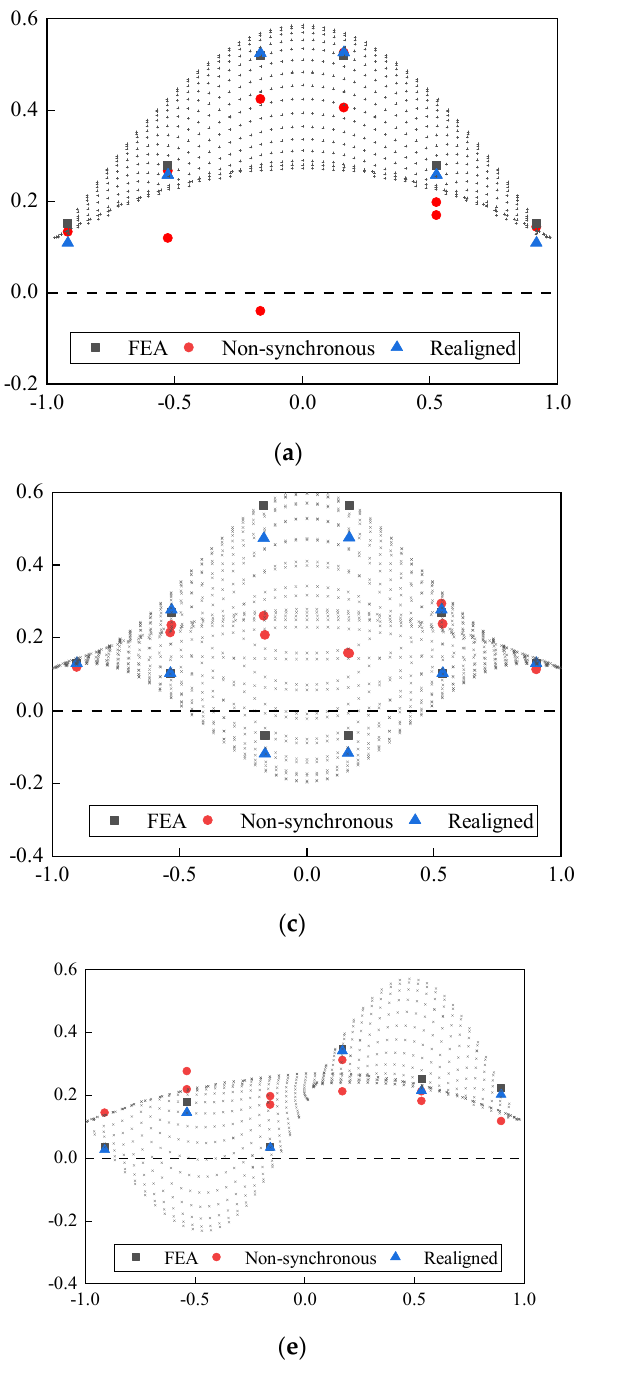
Figure 20. Mode shapes of the first 3 modes of NSSO identified from aligned acceleration and realigned acceleration: ( a ) E-W Projection of 1st mode, ( b ) N-S Projection of 1st mode, ( c ) E-W Projection of 2nd mode, ( d ) N-S Projection of 2nd mode, ( e ) E-W Projection of 3rd mode, and ( f ) N-S Projection of 3rd mode.